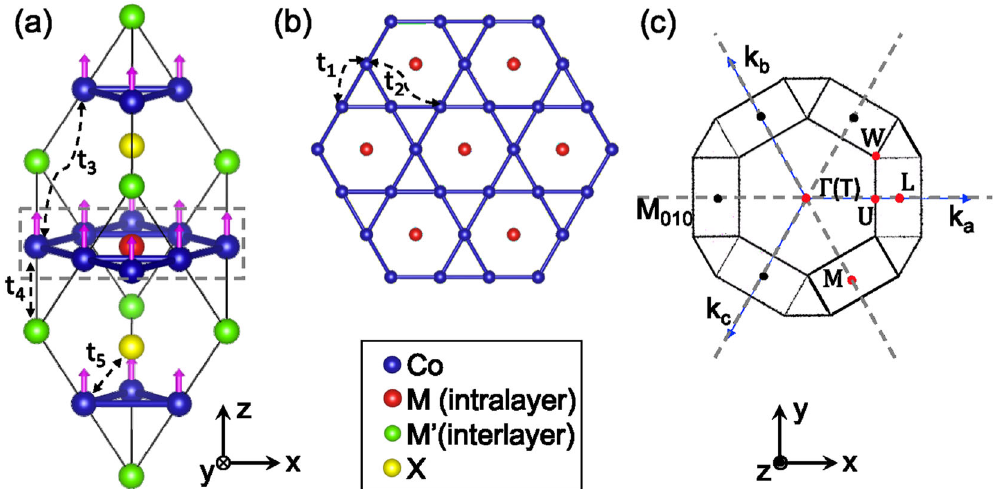
Fig. 1 The crystal structure of Co-MM ’ -X and tight-binding parameters. a The crystal structure of shandite Co-MM ’ -X (the pink arrows represent the orientation of spin). b The Kagome plane embedded in the shandite structure (highlighted by the dotted gray line in a ); t 1 and t 2 represent the NN and NNN hopping parameters between Co orbitals in the Kagome plane, respectively; and t 3 , t 4 , and t 5 are the NN hopping parameters between the interlayer orbitals of Co atoms, between the orbitals of Co and M ’ , and between the orbitals of Co and X, respectively (see the main text for details). c The BZ for the shandite structure, where the dotted lines indicate the k b = k c mirror plane (M 010 in real space) as well as the equivalent mirror planes owing to the C 3 z